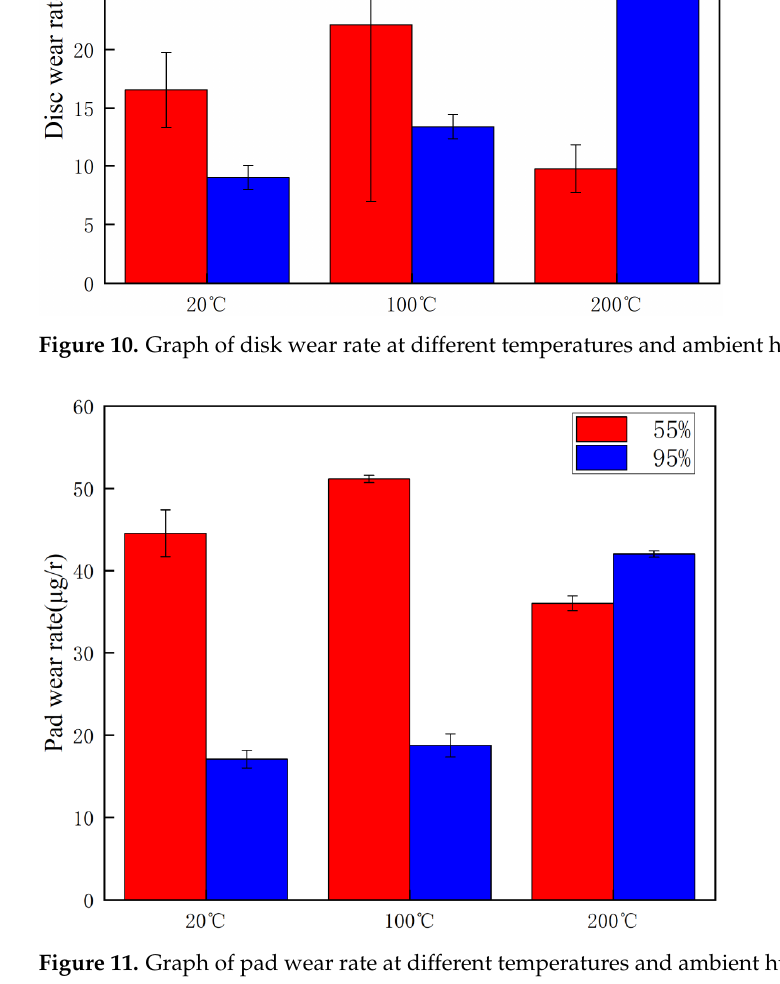
Figure 11. Graph of pad wear rate at different temperatures and ambient humidity.